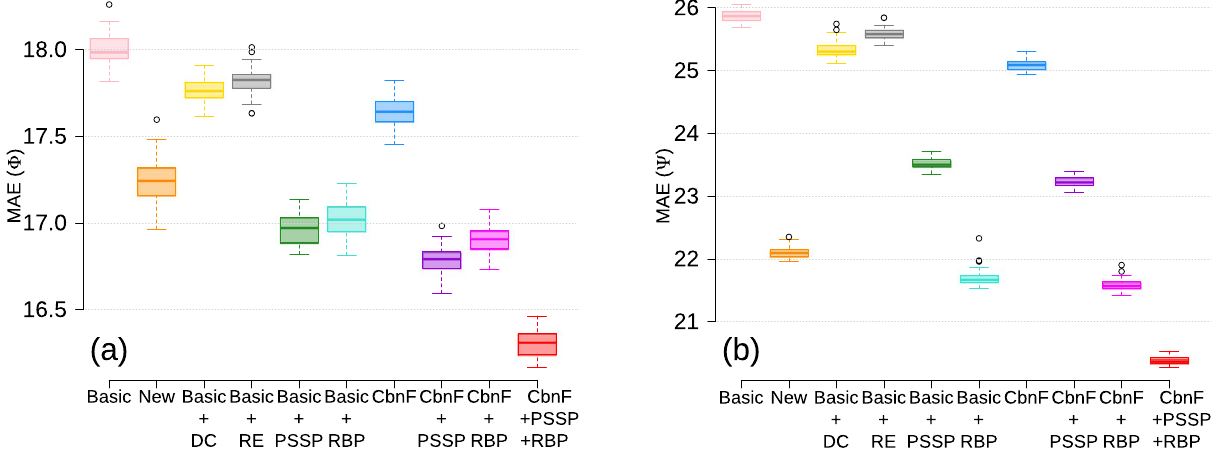
Figure 2. Comparison of prediction performance using different combinations of features on the D2020 dataset. The MAE as measurements between the predicted and experimental values of ( a ) the torsion angle φ and ( b ) the torsion angle ψ , respectively.